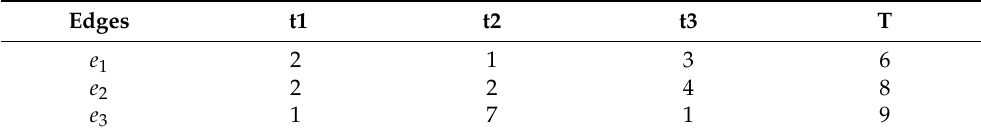
Figure 5. Algorithm example: communication graph constellation at three points in time (t1–t3). The optimal tree (T) and the algorithm result (T’) on trees (t1) and (t2), which is not optimal. Table 2. MST algorithm